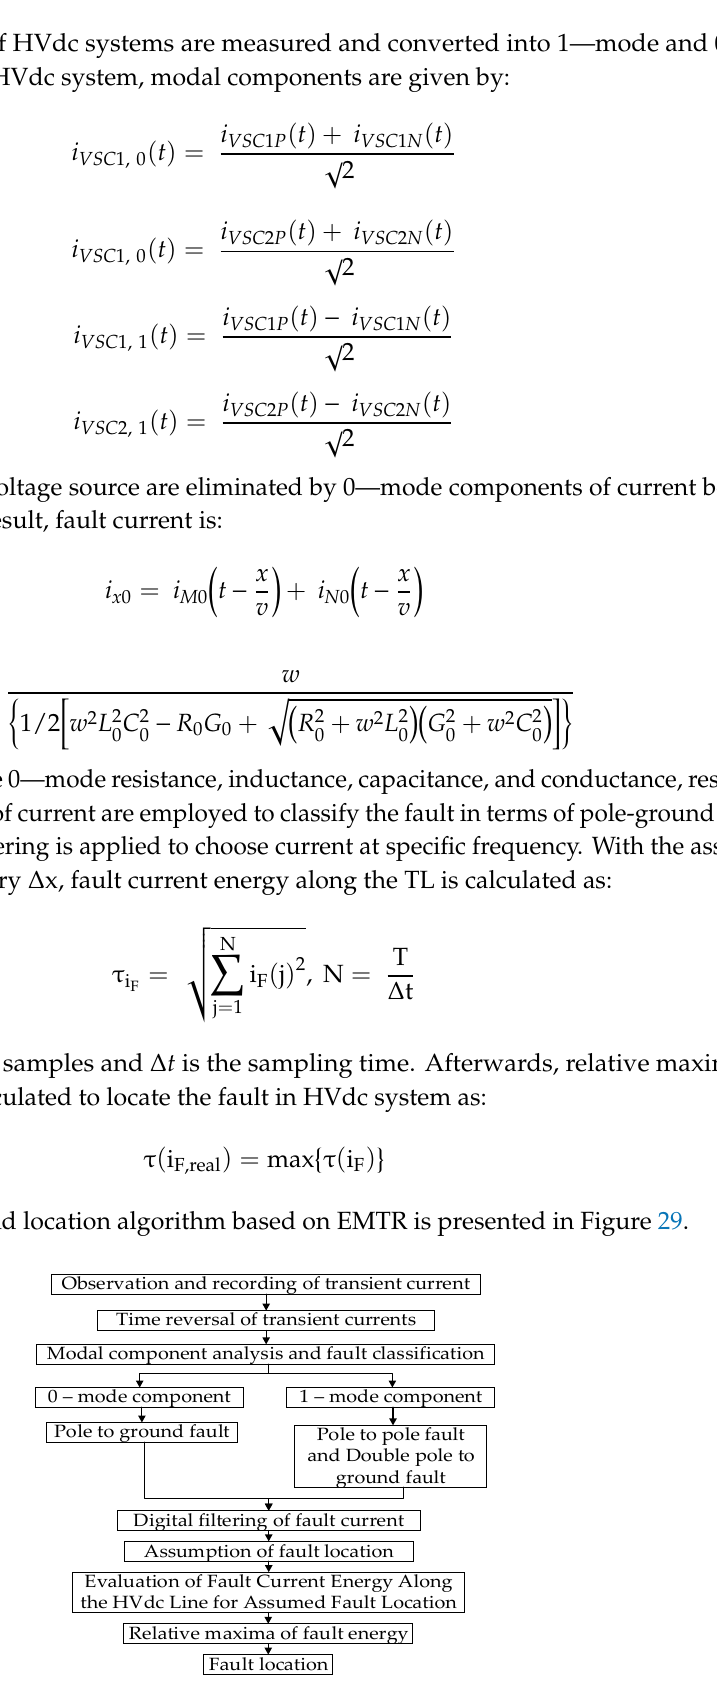
Figure 29. Fault classification and location algorithm based electromagnetic time reversal (EMTR).